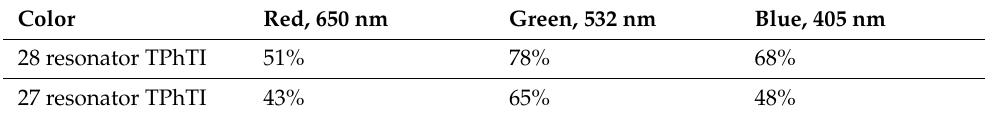
Table 1. TPhTI performance is measured as the relative beam intensity of the edge trajectory.